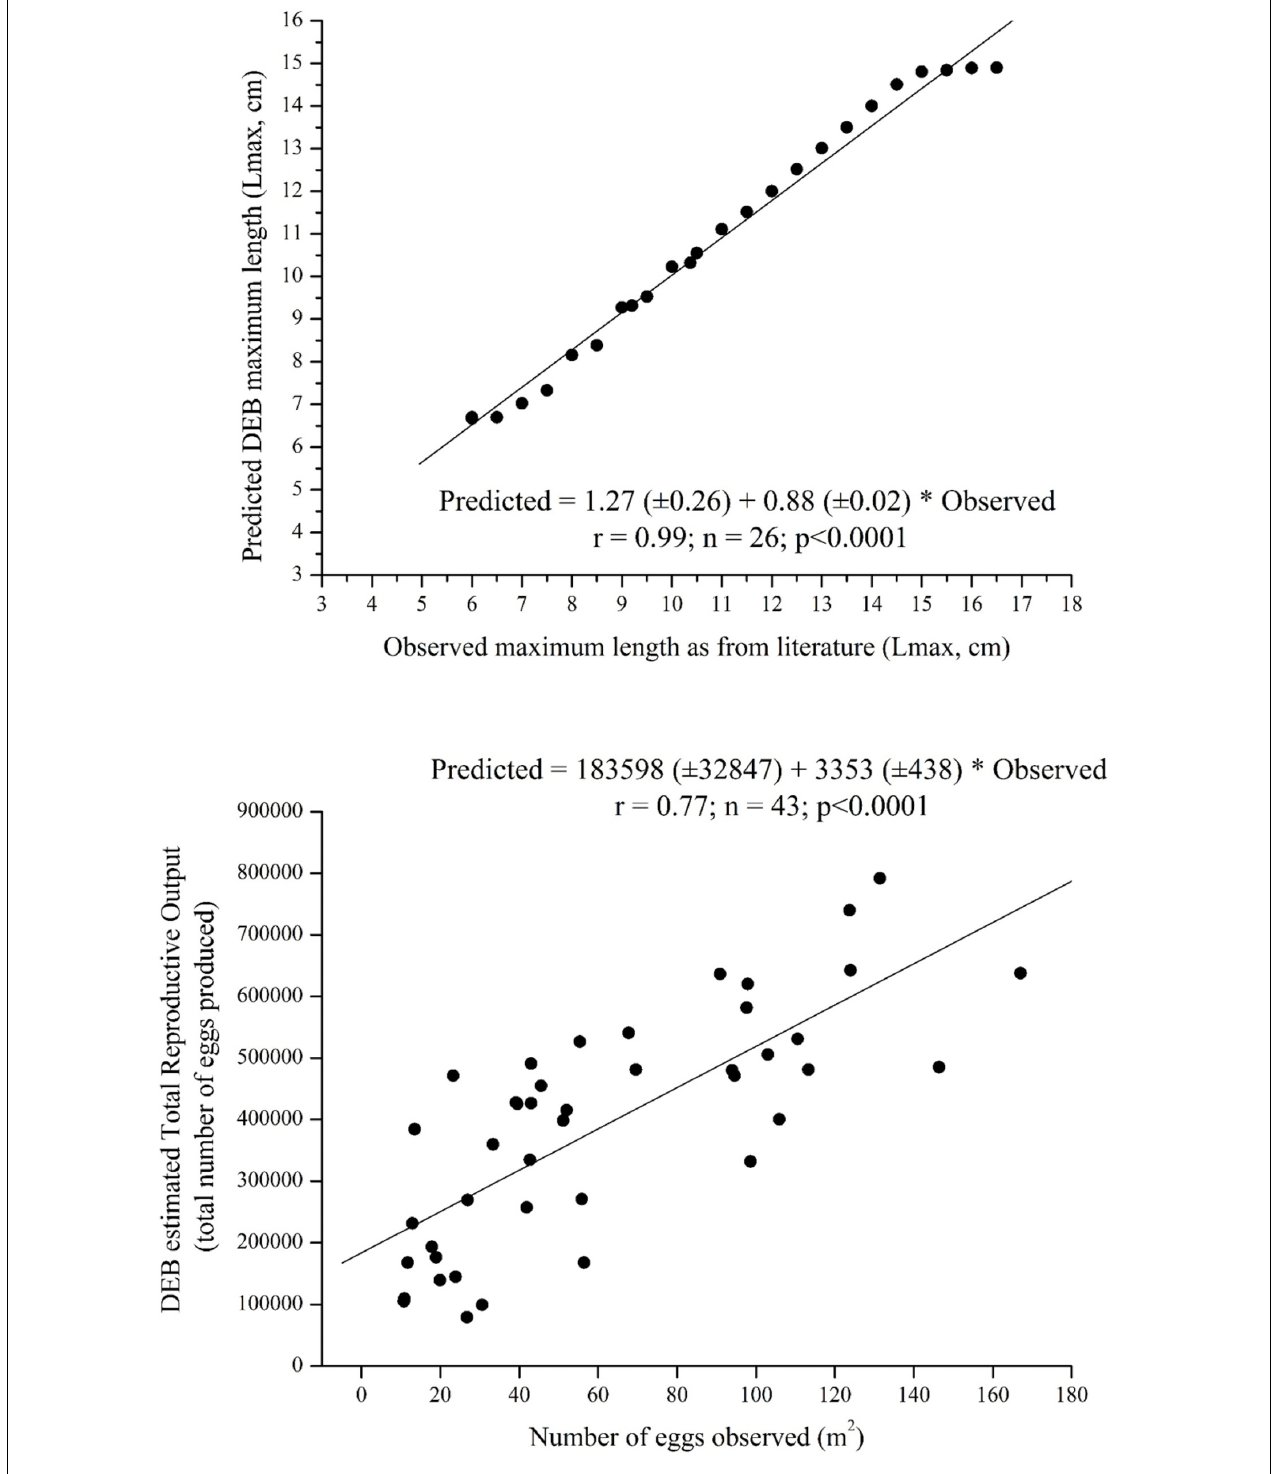
FIGURE 2 | Model validation. Regression lines between observed and predicted data, equation and significant values are reported. Upper panel, Lmax outputs simulations validated by using data extracted from literature (Basilone et al., 2004, 2006). Lower panel, TRO outputs simulations validated by using data